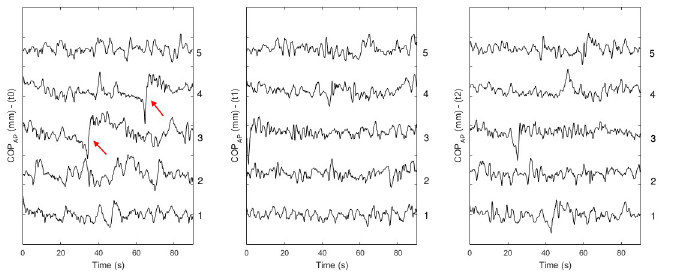
Fig 2. Data acquisition visual exclusion criteria. Example of COPs signal in the anteroposterior direction acquired from a subject in one of the electrical stimulation protocols. From left to right: acquisitions obtained before (t0), during (t1) and after (t2) the electrical stimulation protocol. In (t0), acquisitions 3 and 4 presented periods of expressive anomalous dynamics (red arrows), and were excluded from the final